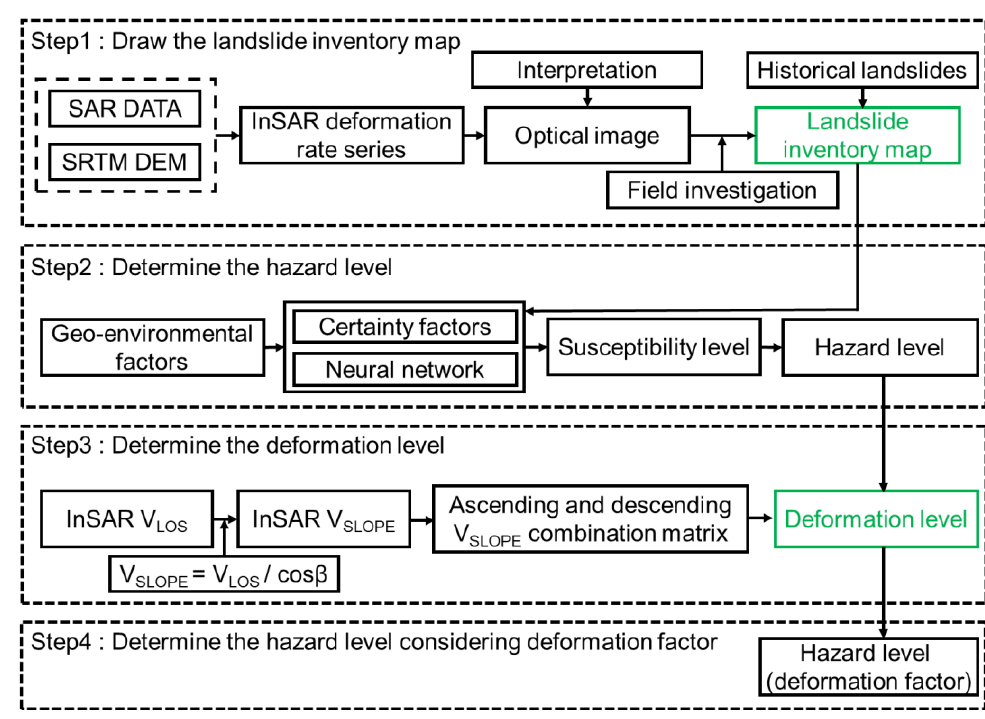
Figure 3. Technological flowchart of this study.